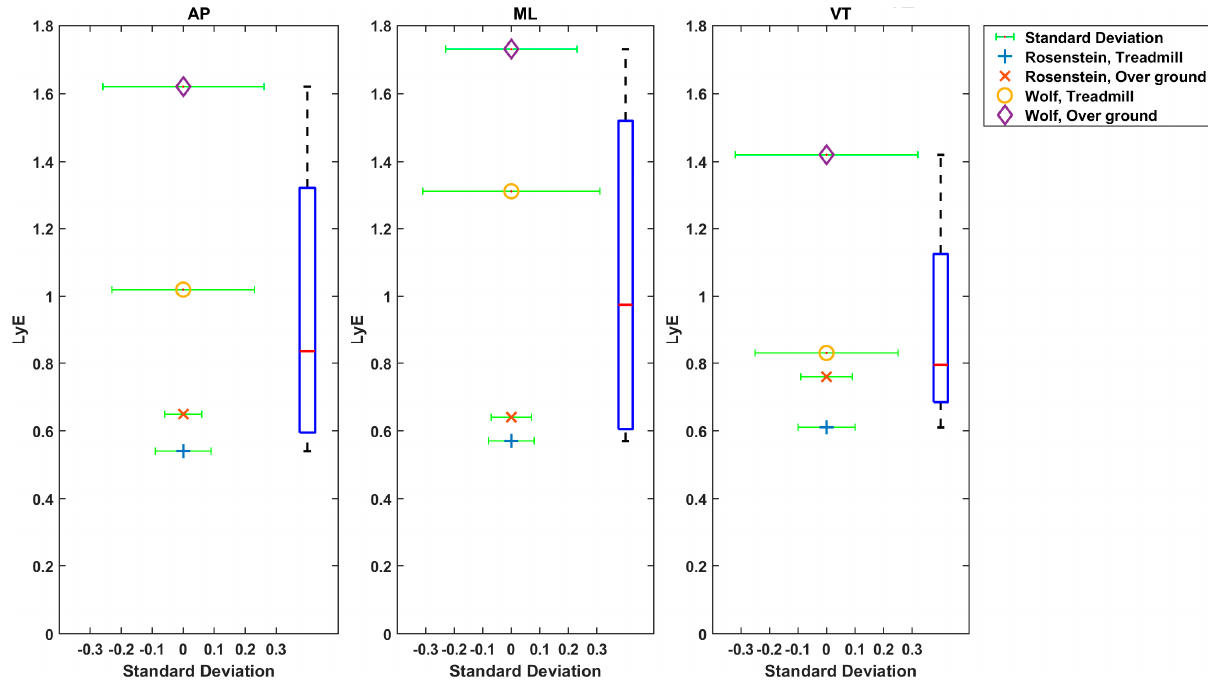
Figure 3. Estimated Mean (x axis) and SD (y axis) LyE values by Rispens et al. (2016).